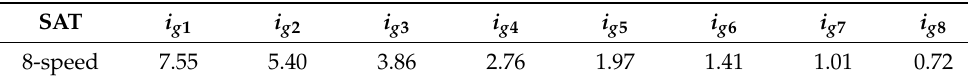
Table 3. The gear ratio of the eight-speed